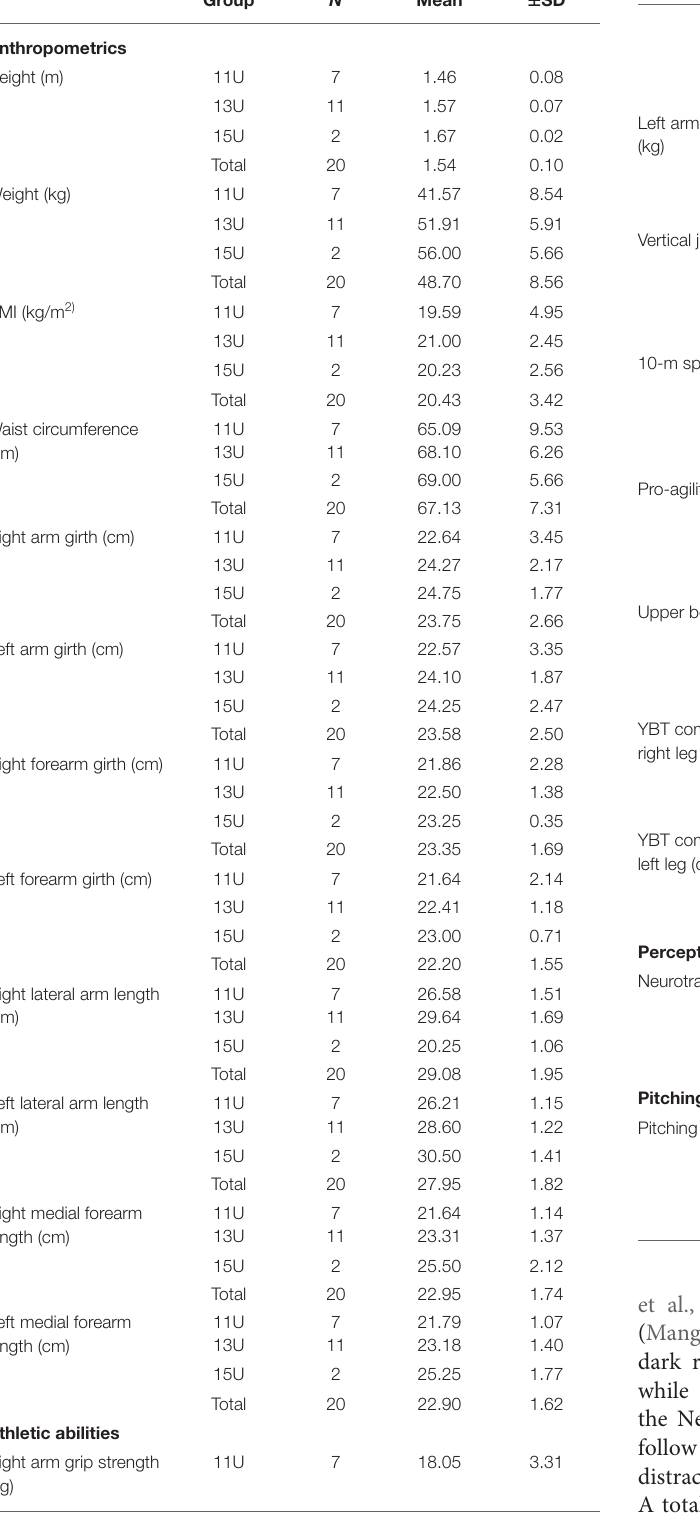
TABLE 4 | Results of anthropometric, athletic ability, and perceptual-cognitive skill assessments of female athletes. Group N Mean ± SD